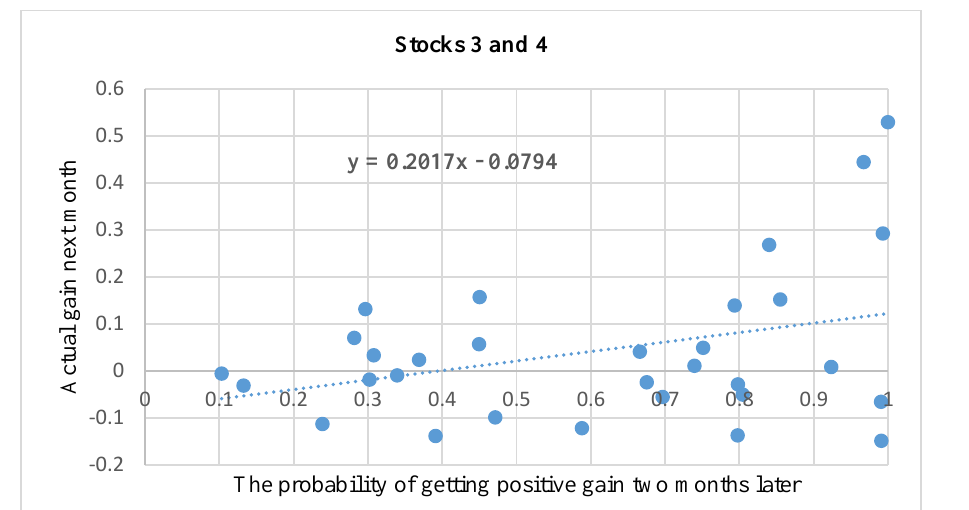
Fig. 4. The results of the regression of actual gain next month on the probability of getting positive gain two months later when stocks 3 and 4 are